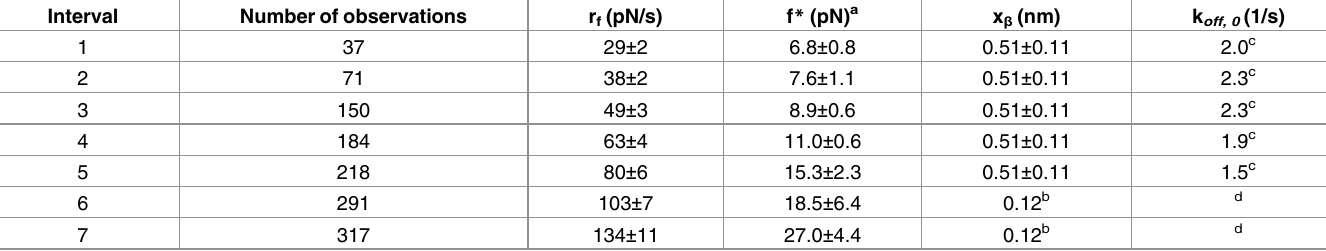
Table 2. Estimated parameters characterizing the energy landscape of the MUC1(Tn)—MGL interaction. Interval